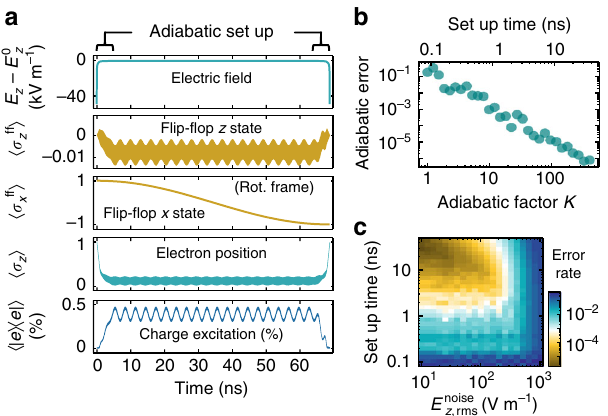
Fig. 3 High- fi delity adiabatic z -gates. a Time-evolution of an adiabatic ( K = 50) π z -gate on state g j i (cid:9) #*j i þ "+j ið Þ = and fl ip- fl op/charge states. Outer brackets denote the expectation value of ¼ "+j i "+h j (cid:3) #*j i #*h j and σ ff an operator. σ ff z